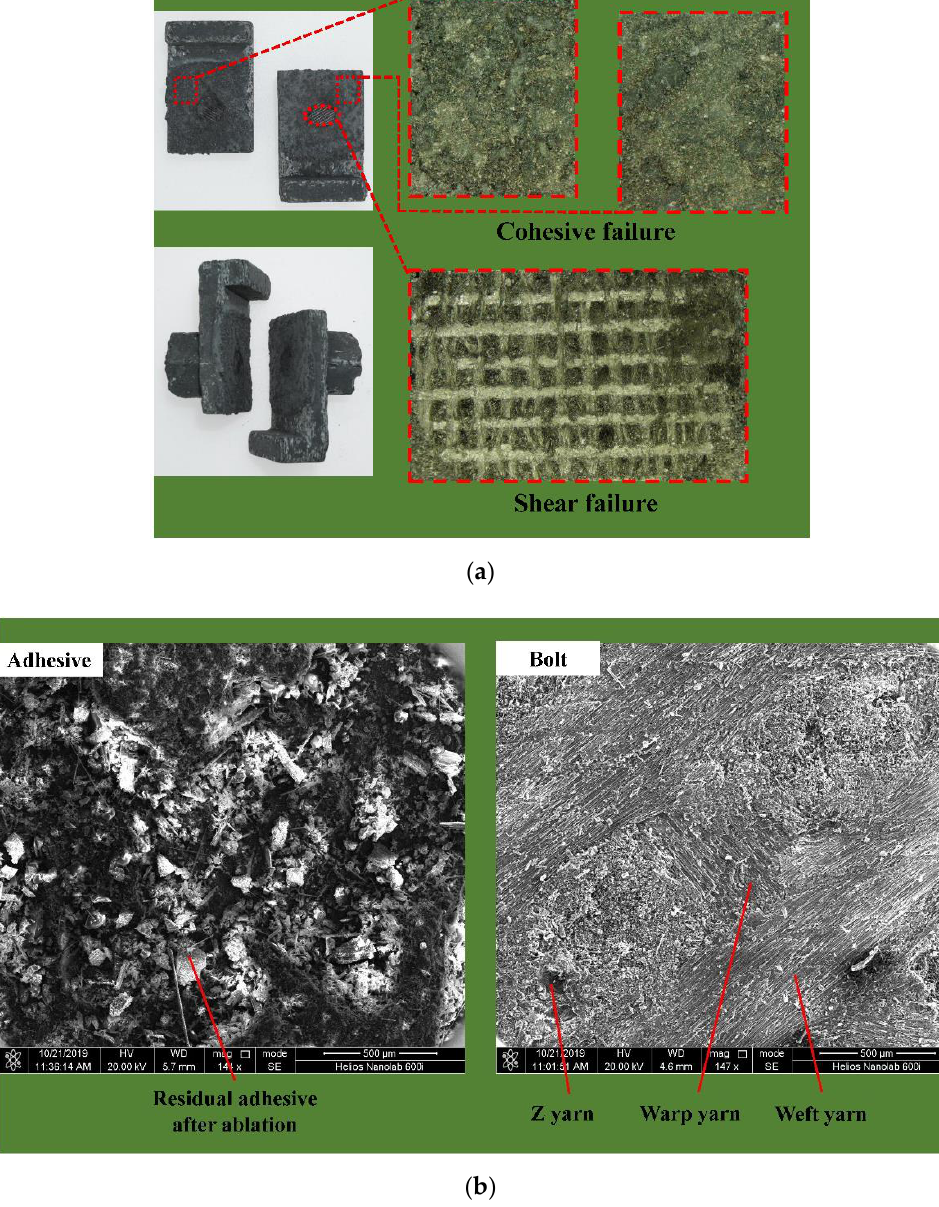
Figure 7. ( a ) Failure morphology observed by the digital microscopic system; ( b ) failure morphology observed by scanning electron microscopy.